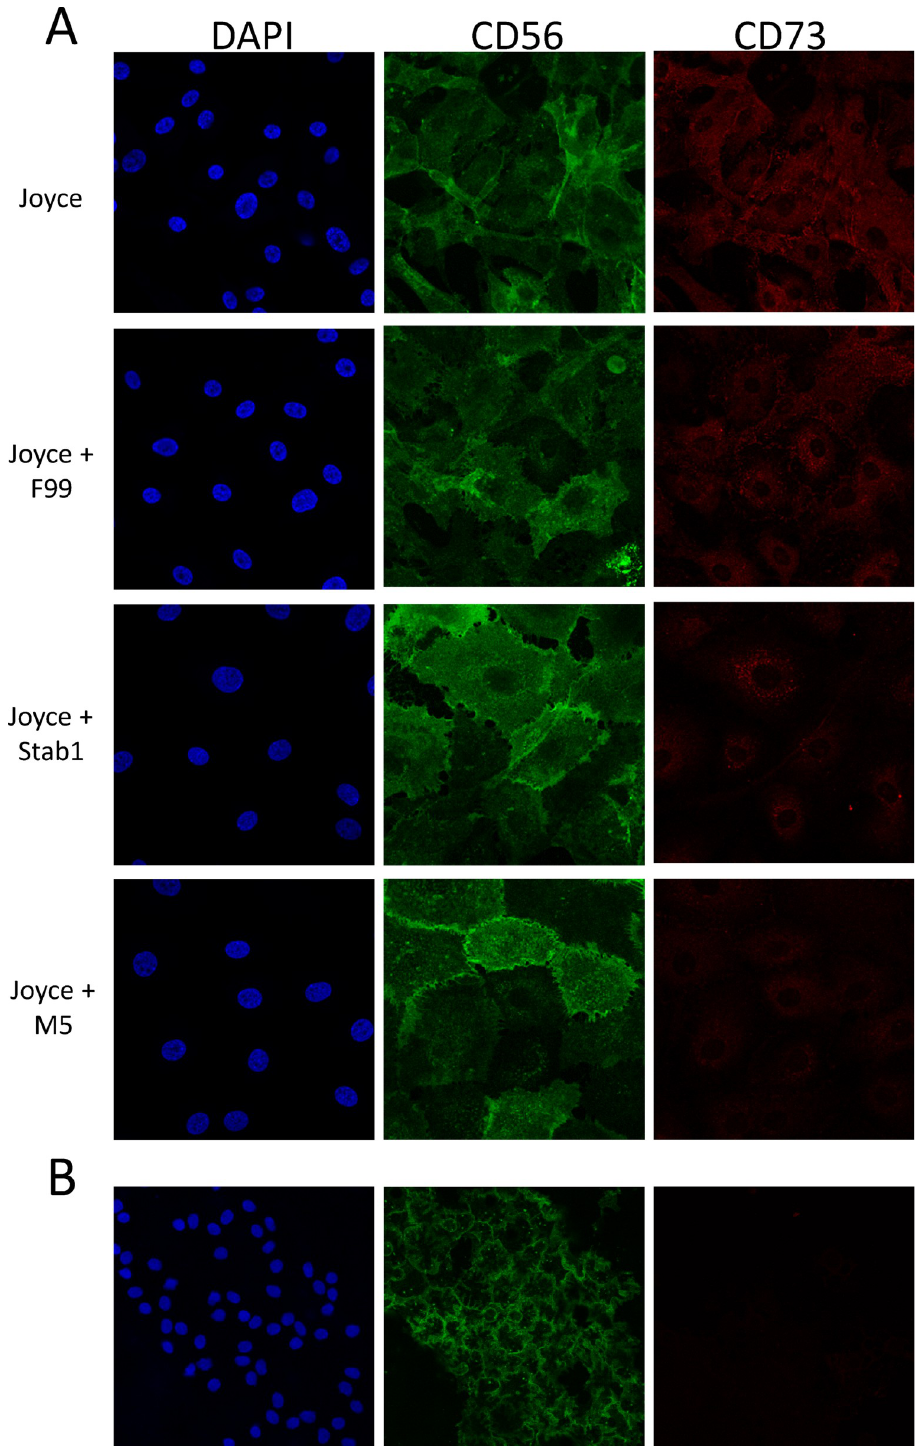
Fig 7. Expression of CD56 and CD73 in FECD-HCECs in various culture conditions. A) Representative images of FECD-HCECs proliferated in Joyce’s medium until confluent and changed to indicated maturation media for 12 days. Cells were stained for CD56 (green) and CD73 (red) and counterstained with DAPI (blue) to show nuclei. B) FECD patient derived CE tissue stained for CD56 (green) and CD73 (red), and counterstained with DAPI (blue) to show